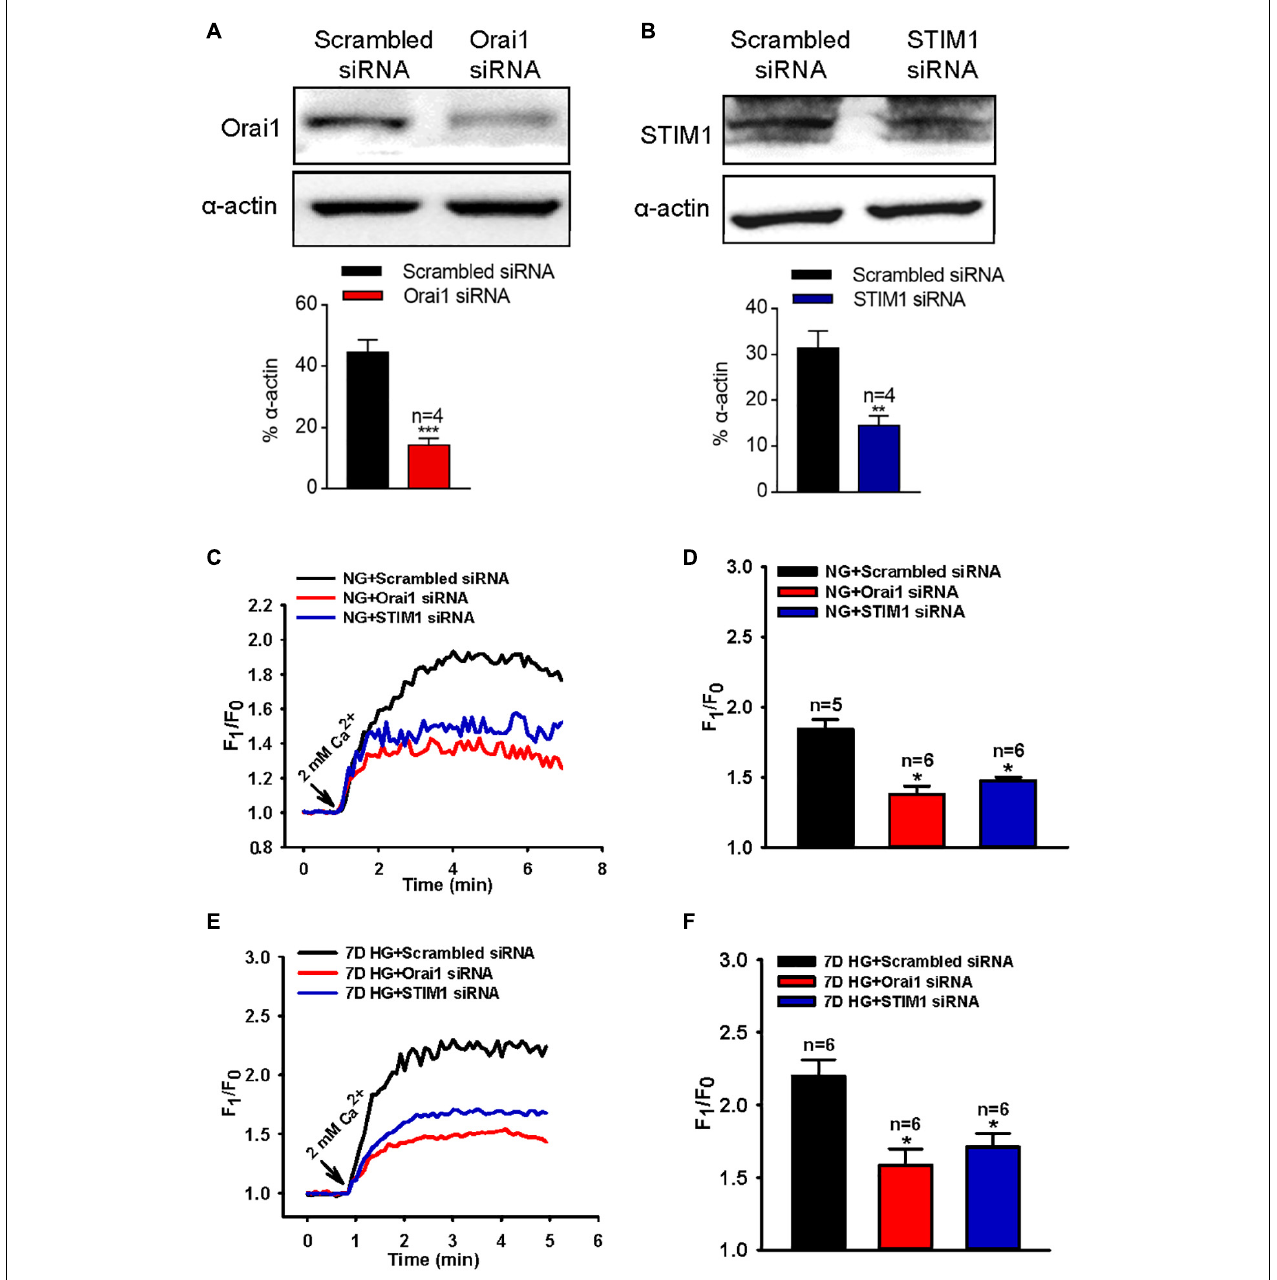
FIGURE 3 | Effect of Orai1 and STIM1 siRNAs on store-operated Ca 2 + entry (SOCE) in MUS-M1 cells. (A,B) Representative immunoblotting images showing Orai1 and STIM1 expression levels in MUS-M1 cells transfected with Orai1 siRNA (A) , STIM1 siRNA (B) , or scrambled control siRNA. **, and *** denote P < 0.01, and P < 0.001, respectively. Representative traces (C,E) and summarized data (D,F) showing the alterations in [Ca 2 + ] i (SOCE) evoked by extracellular application of 2 mM Ca 2 + after the treatment of 100 µ M carbachol for 10 min in Ca 2 + -free solution to deplete internal Ca 2 + stores in MUS-M1 cells cultured in normal glucose (NG, C,D , 5.6 mM D -glucose + 20 mM α -mannitol) or high glucose (HG, E,F , 25 mM D -glucose) medium for 7 days. Alpha-actin was used as a loading control. Values are shown as the mean ± SEM ( n = 5–6); * P < 0.05, scrambled siRNA vs. Orai1 or STIM1 siRNA